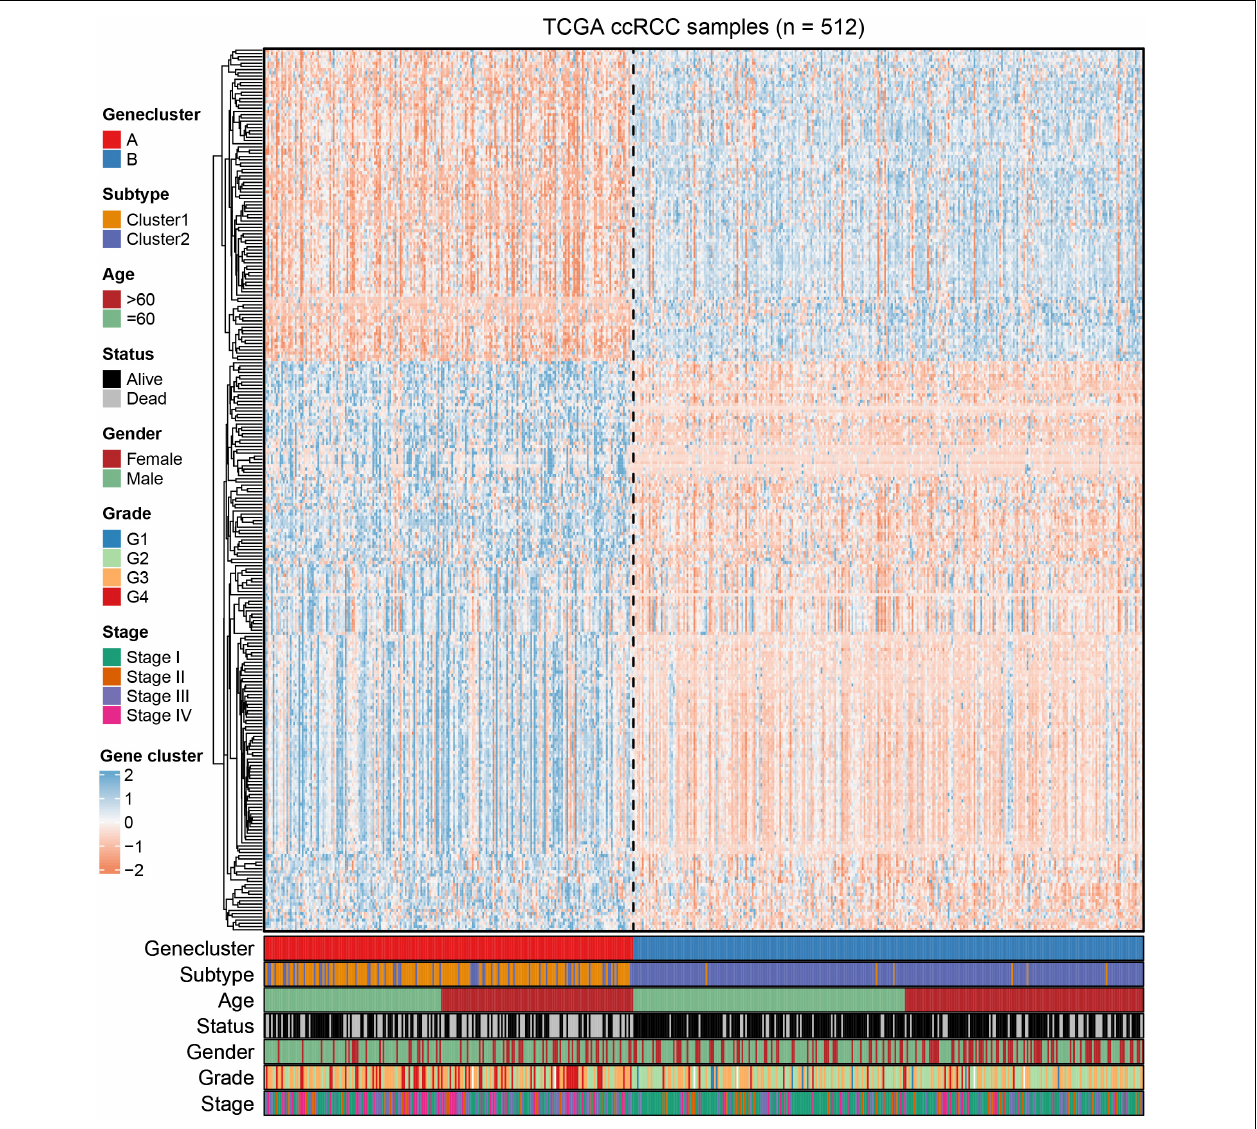
FIGURE 8 | The NMF clustering of DEGs in TCGA cohorts to categorize patients into two genomic subtypes (A and B). The gene clusters, immune-related subtype, tumor stage, age, survival status, gender, grade, and age were termed as patient annotations.